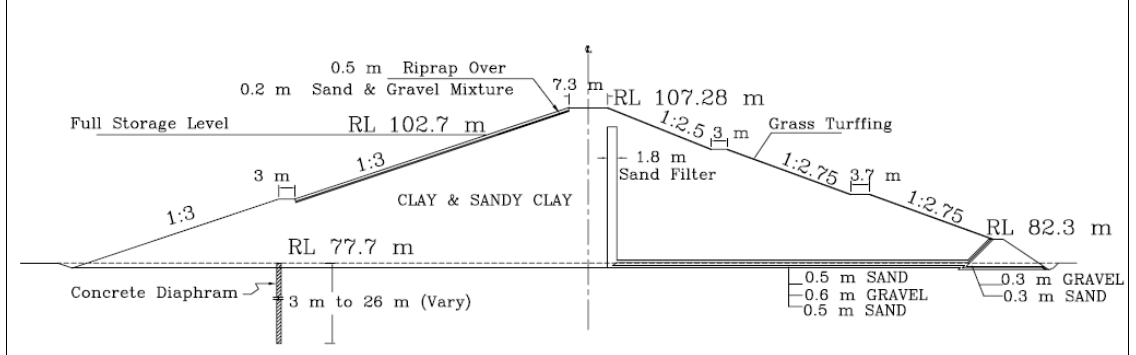
Figure A2. Typical cross-section of Swa Dam (IWUMD).